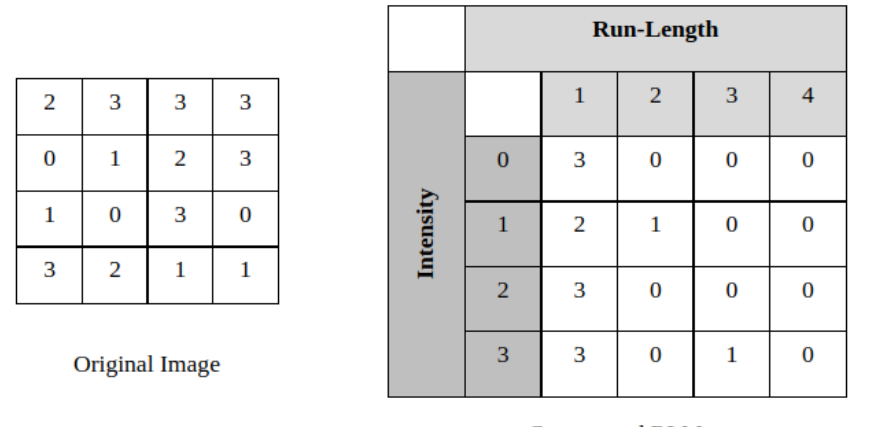
Figure 2. Construction of the RLM for the 0 ◦